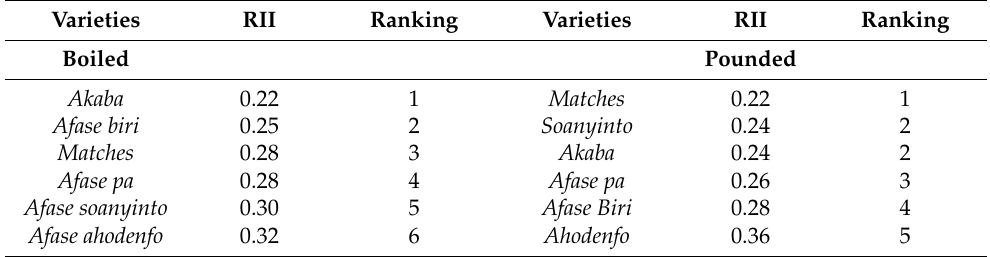
Table 3. Relative index for choice of yam variety for overall acceptability of boiled and pounded yam ( D. alata ).